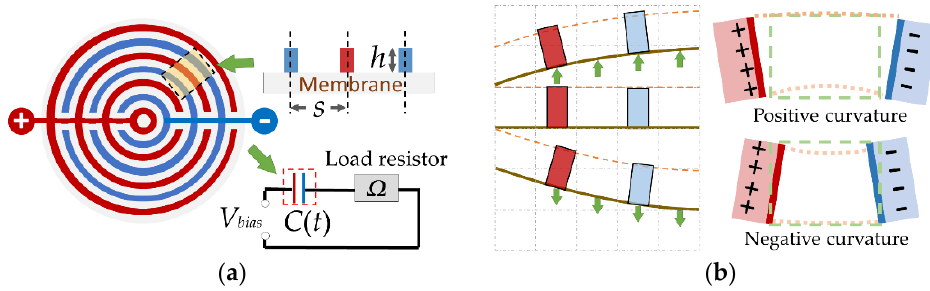
Figure 2. Schematic of the circular membrane energy harvester: ( a ) nomenclature of the circular membrane of variable capacitance C( t ) and the equivalent circuit diagram; ( b ) mechanism of the circular membrane energy harvester.